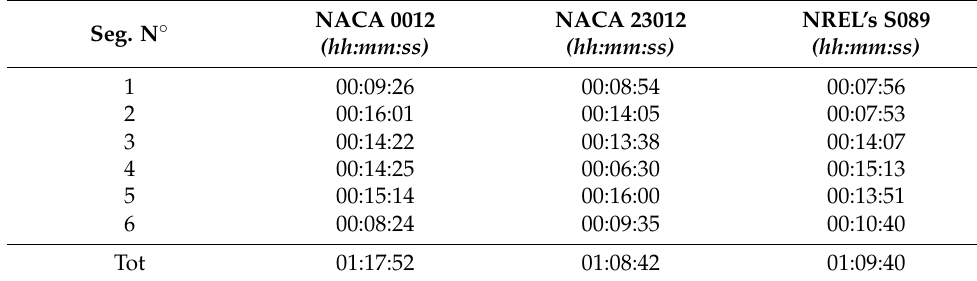
Table 8. New mathematical model fitting process segment-wise computation time.